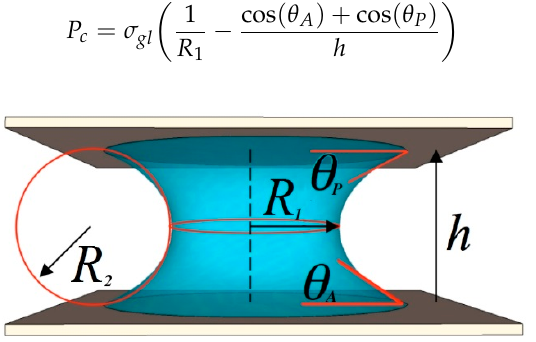
Figure 2. Capillary bridge between surfaces indicating radii of curvature and contact angles.